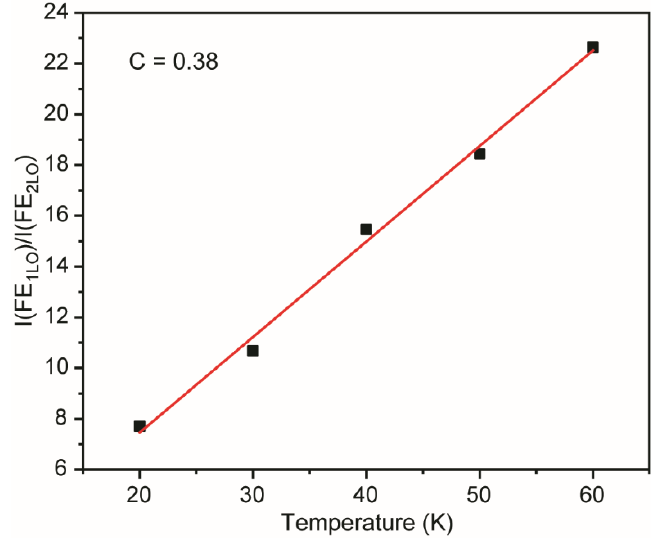
Figure 5. First and second phonon replica intensity linear approximation.